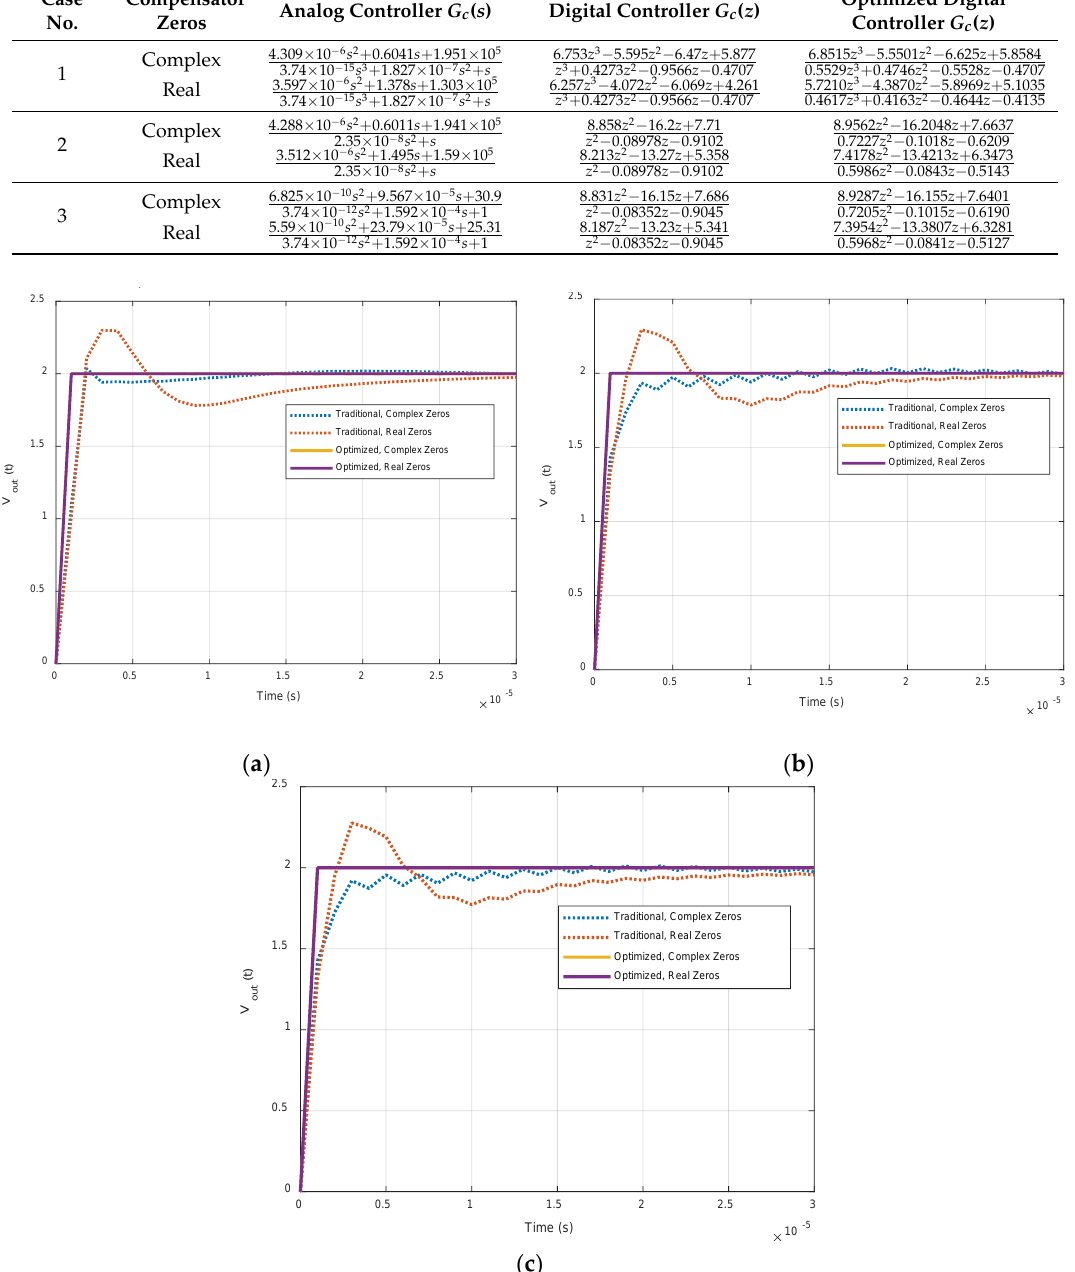
Figure 8. Step response offered by ( a ) case 1, ( b ) case 2, and ( c ) case 3 controllers.